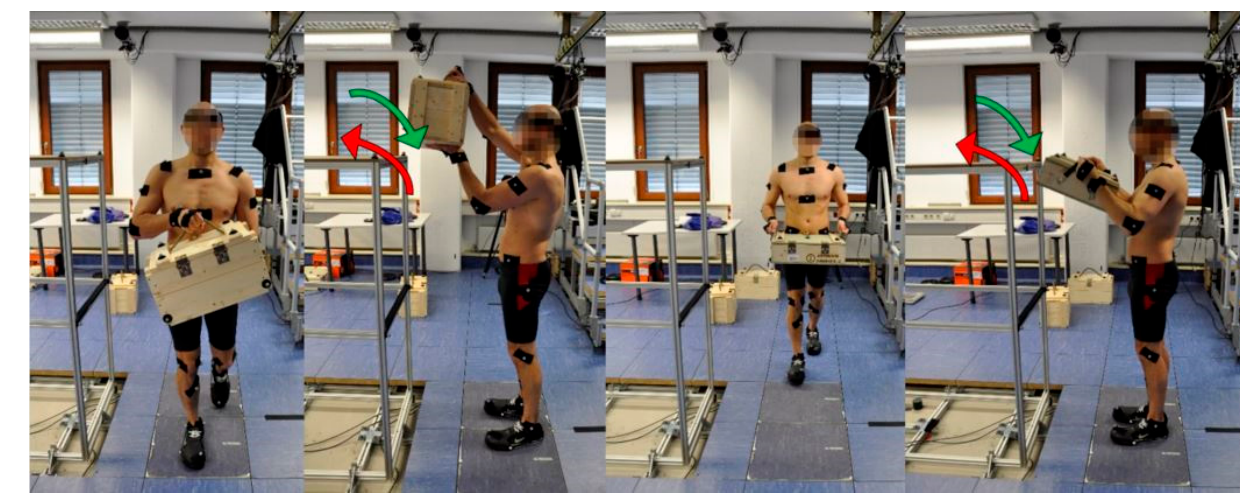
Figure 2. Subject performing motion sequences T1–T6 in the motion laboratory. From left to right: carrying box A (T1), lifting (T2, red arrow) and lowering (T3, green arrow) box A, carrying box B (T4), lifting (T5, red arrow) and lowering (T6, green arrow) box B.